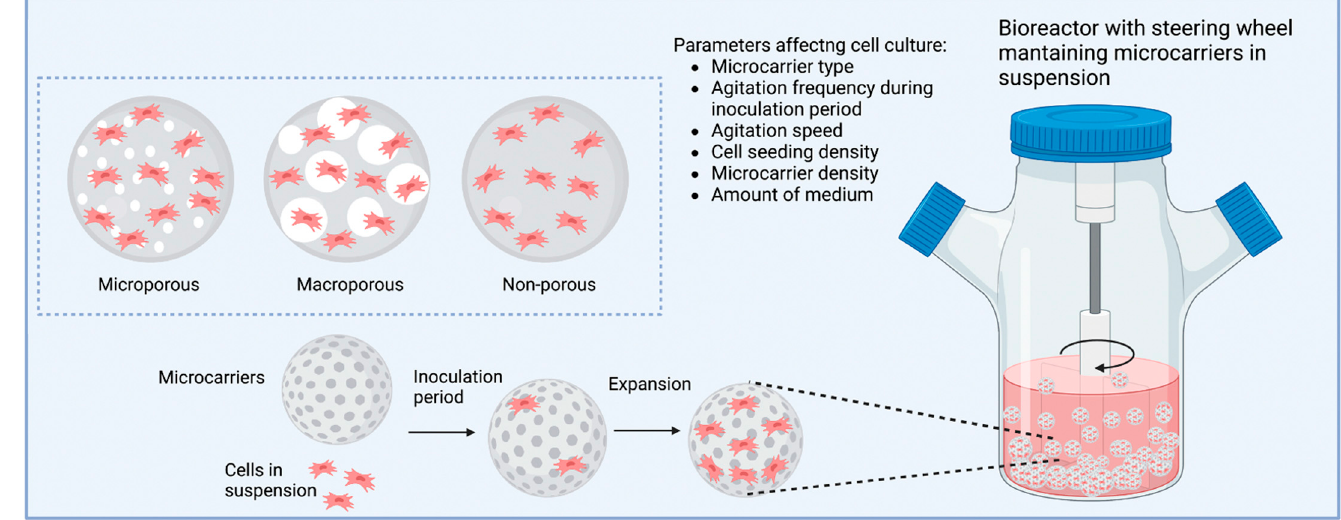
Figure 4. Schematic of cell attachment onto microcarriers and the different parameters affecting their culture.